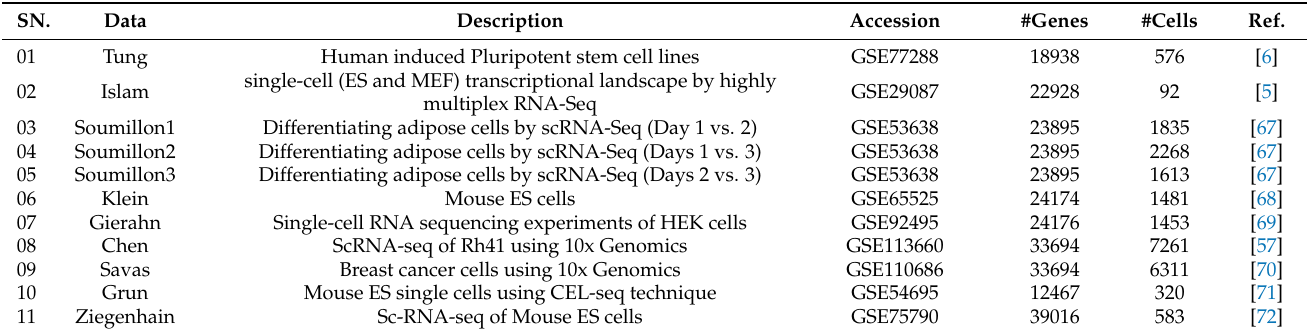
Table 3. List of the scRNA-seq datasets used in this